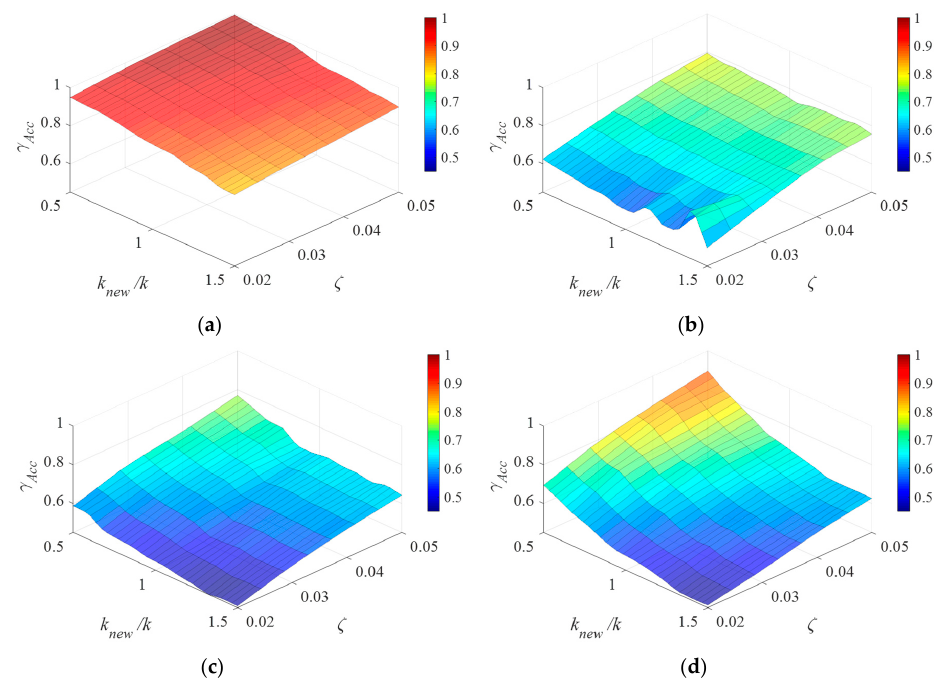
Figure 12. Sensitivity analysis of γ Acc with variation of the structural circular frequency for κ = 0.50 and λ= 1.00 with (a) μ= 0 , (b) μ= 0.10 , (c) μ= 0.25 , and (d) μ= 0.40 .